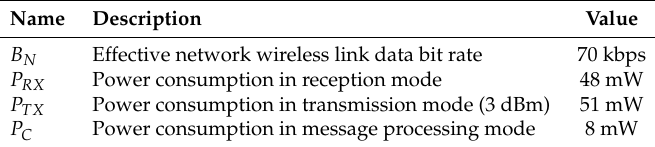
Table 7. Parameters used to characterize the energy consumption of sensor